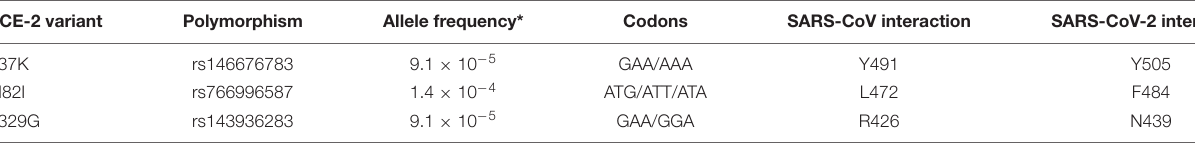
TABLE 1 | ACE-2 missense variants affecting residues involved in SARS-CoV and SARS-CoV-2 spike-protein binding. ACE-2 variant Polymorphism Codons